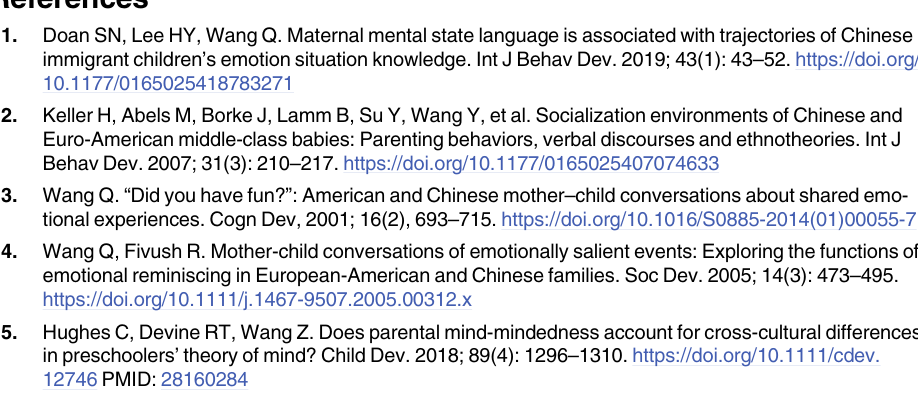
S1 Table. Examples of MS talk used by Western and Chinese mothers. Note . Some